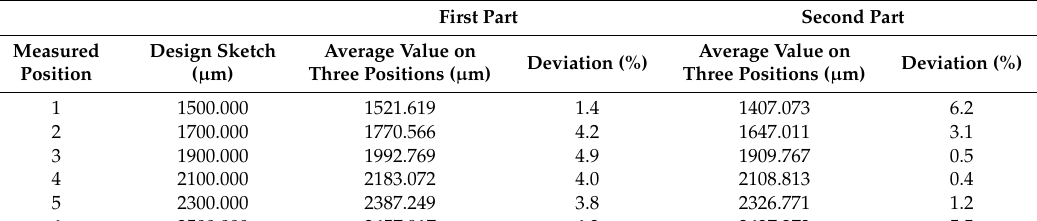
Table 5. Measured dimension of the features on both parts of the specimen printed by the modified scanning strategy.